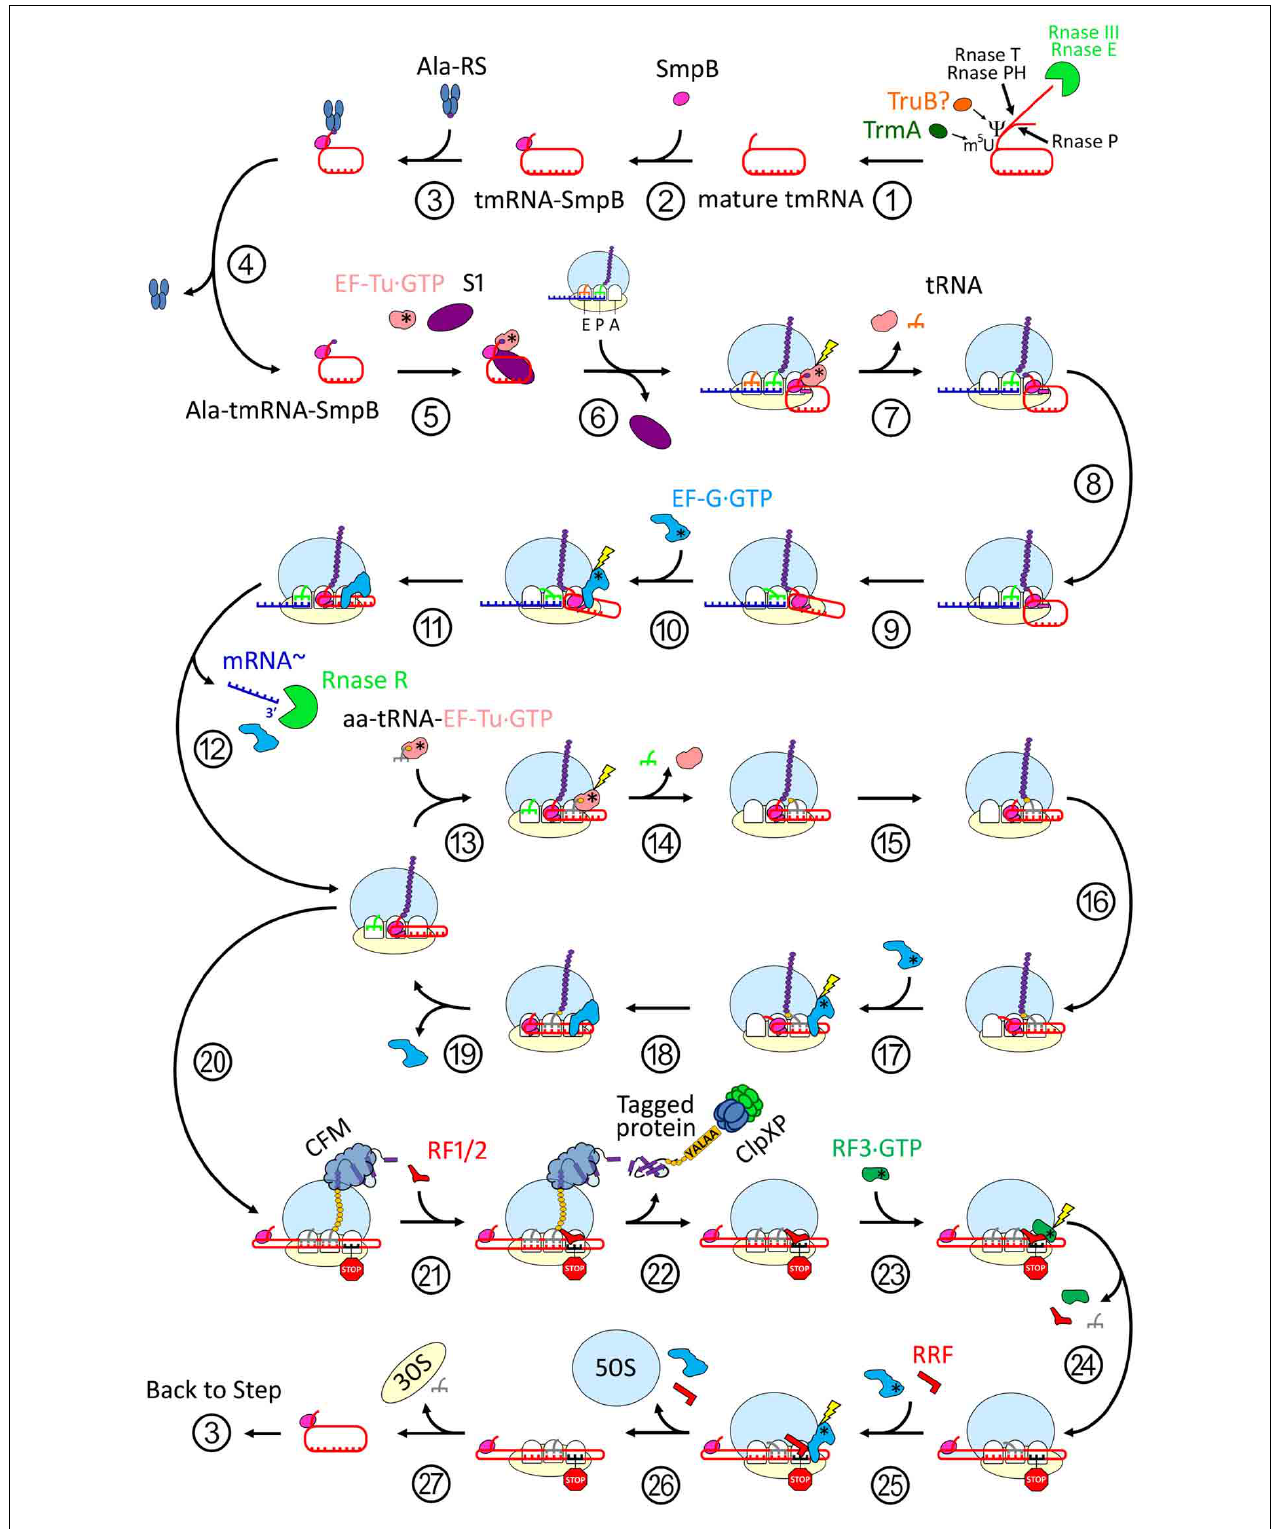
FIGURE 1 | The cycle of trans -translation. Maturation: (1) The tmRNA primary transcript 5 (cid:2) -terminus is processed by the endonuclease RNAse P, while the 3 (cid:2) -terminus is first cleaved by endonucleases RNAses III or E then trimmed by exonucleases RNAses T and/or PH. Nucleotides in the T-loop are